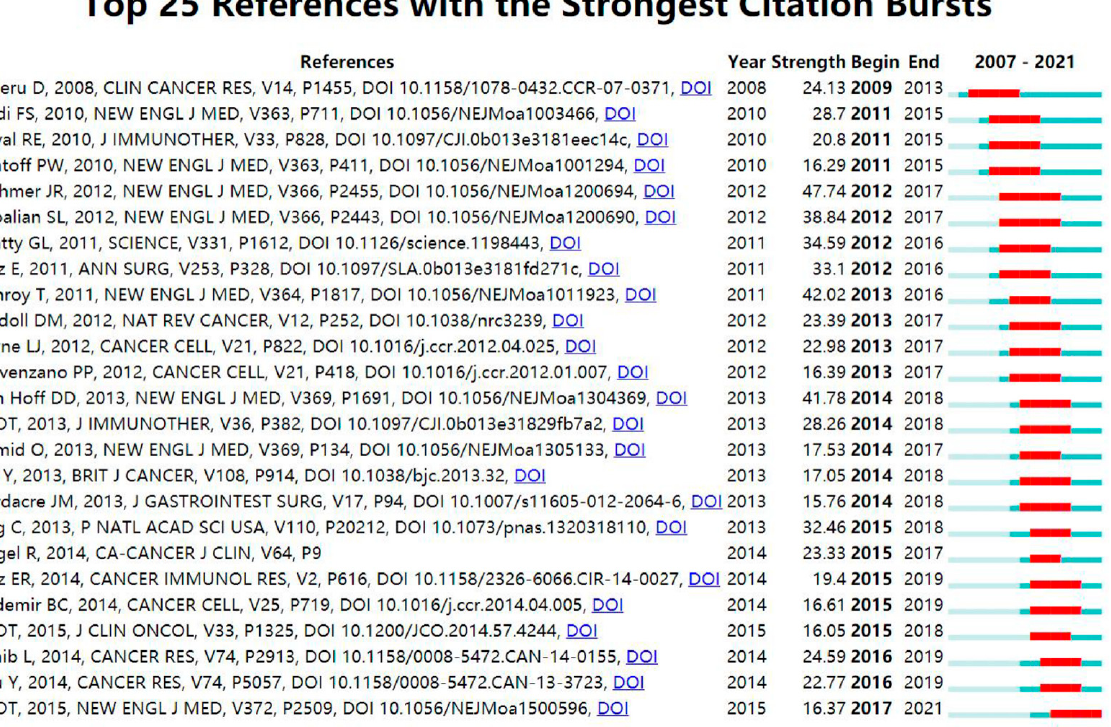
Figure 6. Timeline view ( A ) and cluster view ( B ) of co-citation references related to pancreatic cancer immunotherapy visualized by CiteSpace. Fifteen labeled clusters are colored on the right. The nodes on the line represented the cited references.